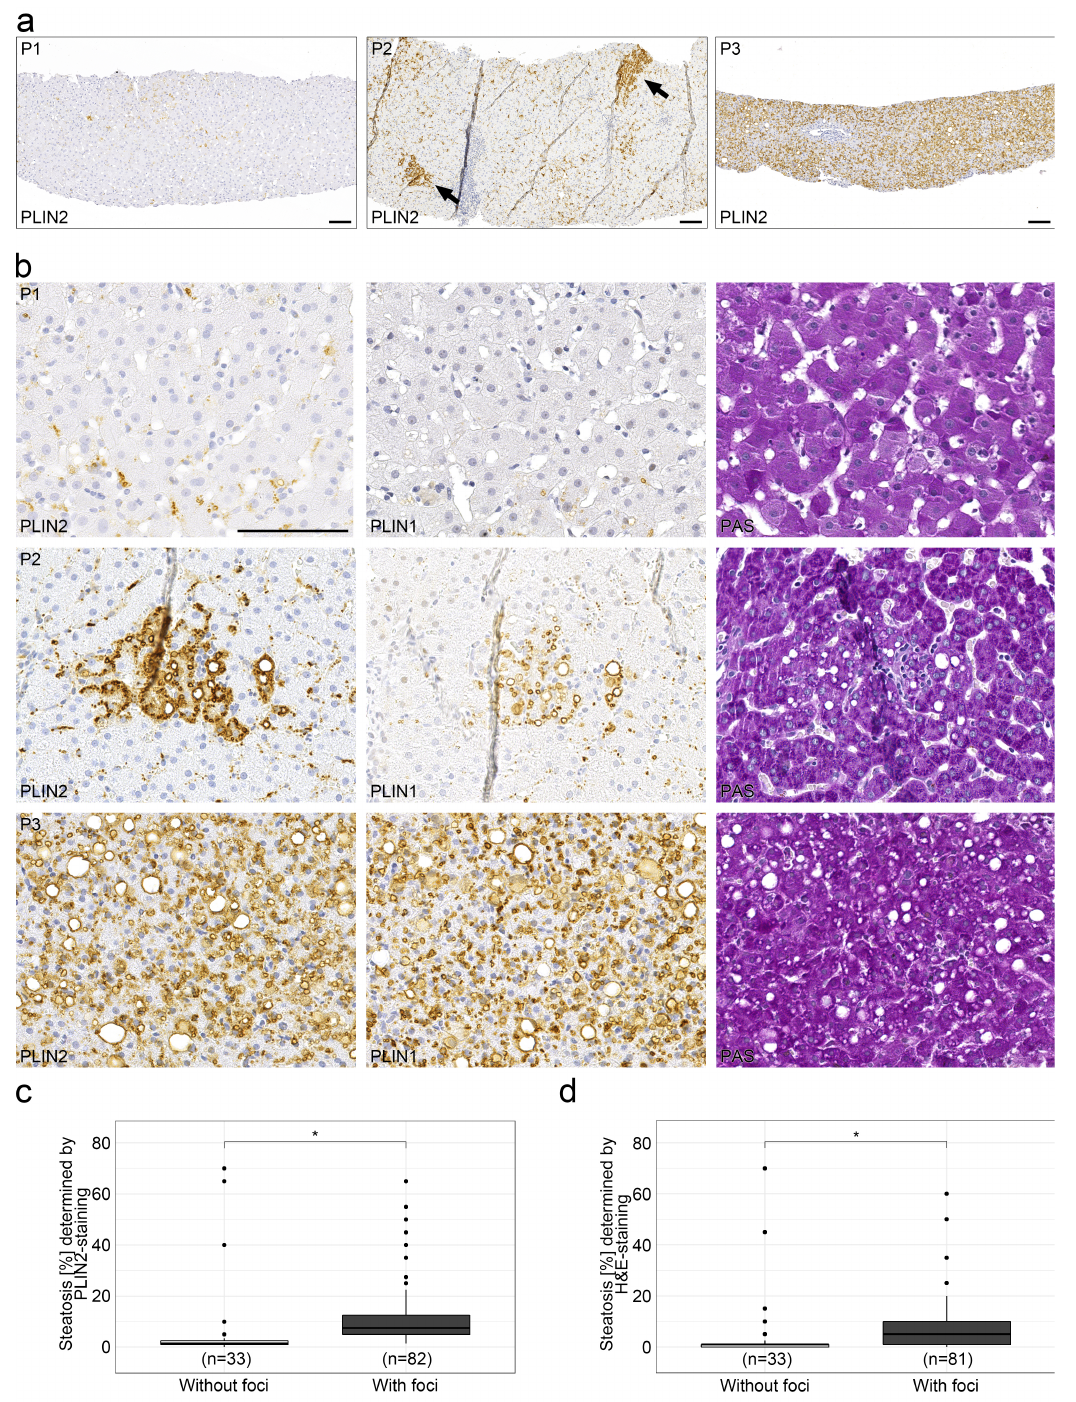
Figure 3. Appearance of perilipin-positive microvesicular steatotic foci with chronic hepatitis C infections. ( a ) Overview of representative immunohistochemical stains for perilipin 2 (PLIN2) in liver biopsies from 3 different HCV patients with no (P1), minor (P2) and a moderate (P3) degree of steatosis. Arrows indicate perilipin 2-positive steatotic foci. Scale bar: 100 µ m. ( b ) Higher magnification of the liver biopsies of the same patients with respective immunohistochemical stains for perilipins 1 and 2 as well as PAS staining. Scale bar = 100 µ m. ( c , d ) Occurrence of steatotic foci with respect to the degree of steatosis (boxplot). Foci were identified by perilipin 2 ( c ) or H&E staining ( d ). Wilcoxon test with p < 0.05 (*) were considered